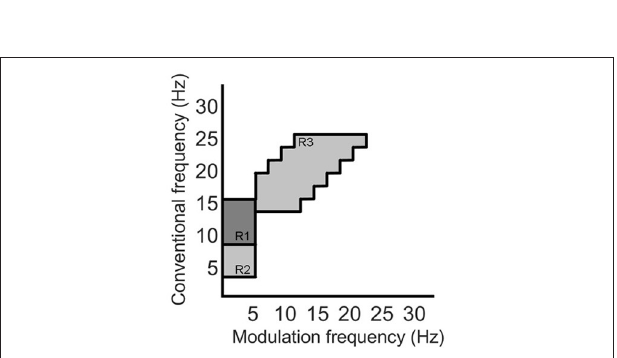
FIGURE 4 | Three regions (patches) identified in the modulation spectral domain to provide best AD diagnostic accuracy, adapted from Cassani and Falk